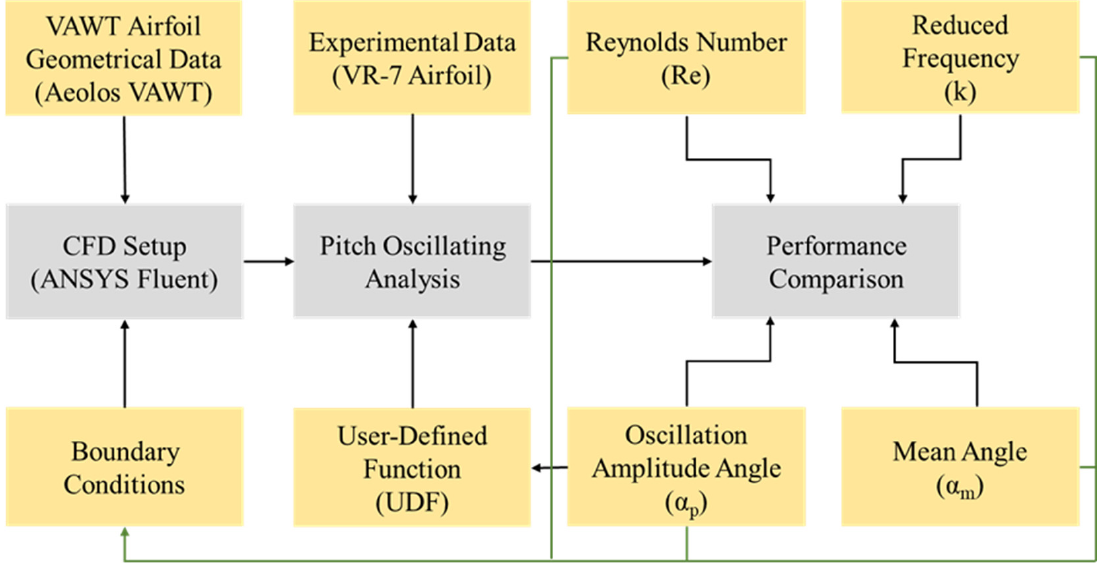
Figure 1. The methodology adopted for analysis of oscillating airfoil.